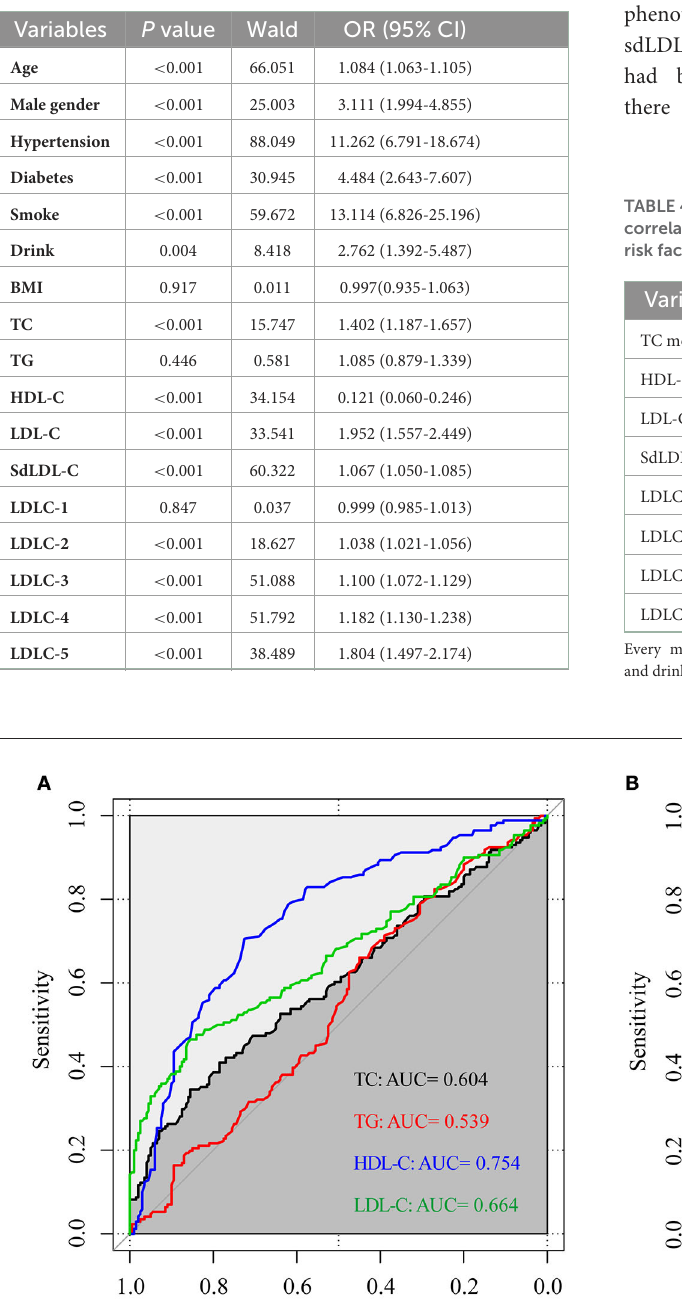
TABLE 3 Risk factors of CAD by logistic regression analysis.